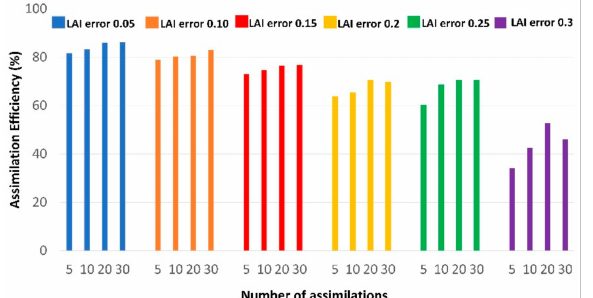
Figure 7. Assimilation efficiency index calculated with synthetic data as described in Section 2.2. Each column represents a different number of assimilations (the value is reported on the x -axis) while each colour represents a different error on “measured” LAI. For simplicity of calculation, AE is valued against